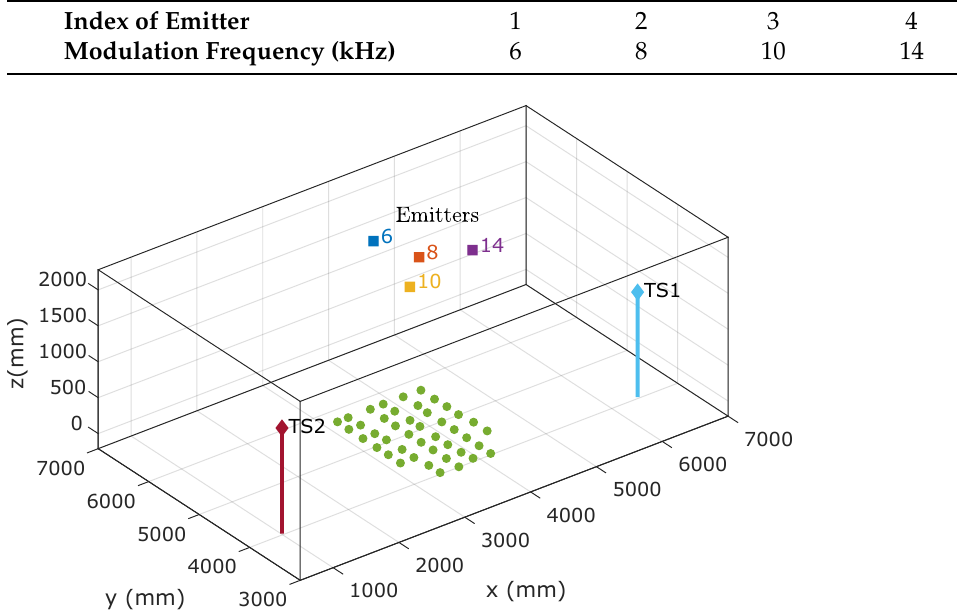
Figure 5. Positions of the emitters, receivers (green), and total stations in the test environment.